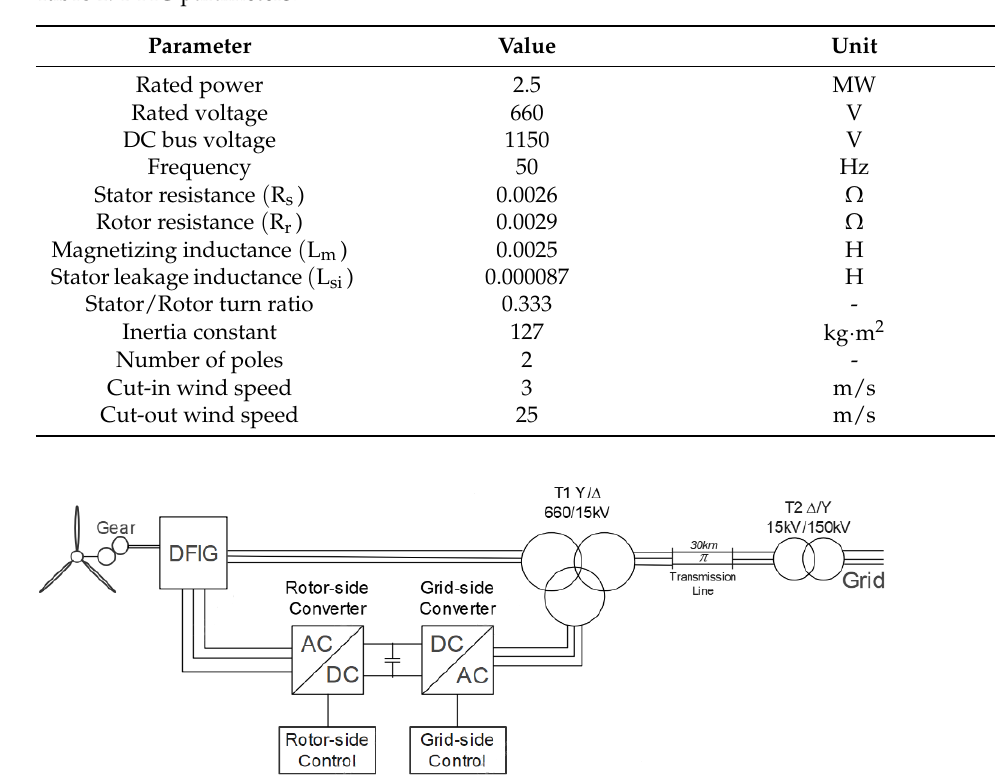
Figure 11. Power curve of the DFIG.